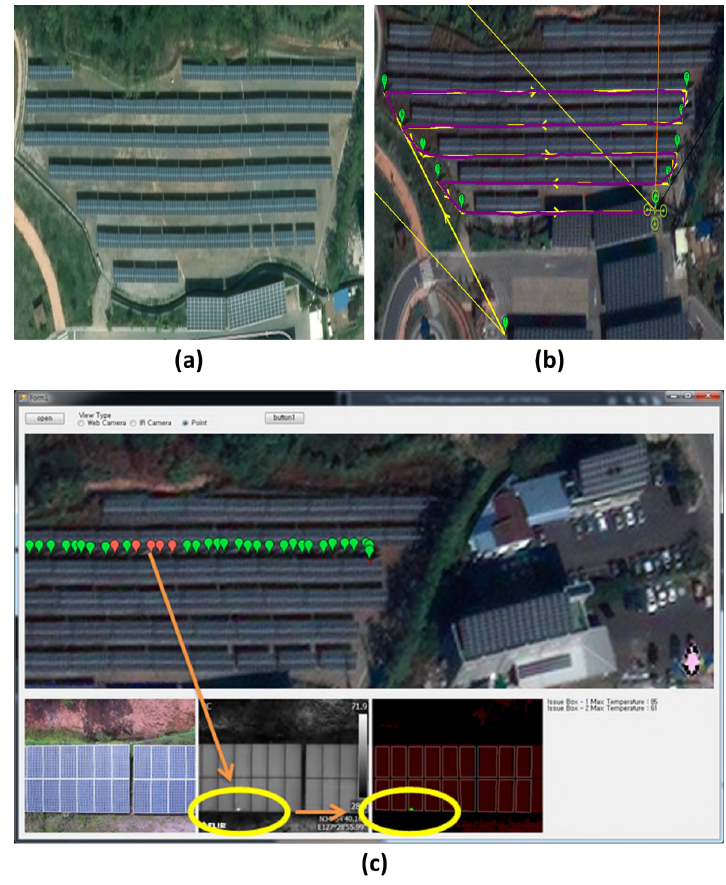
Figure 11. ( a ) Image of overall PV power plant; ( b ) image showing the automatically planned flight path; and ( c ) the final result showing the location of defective PV